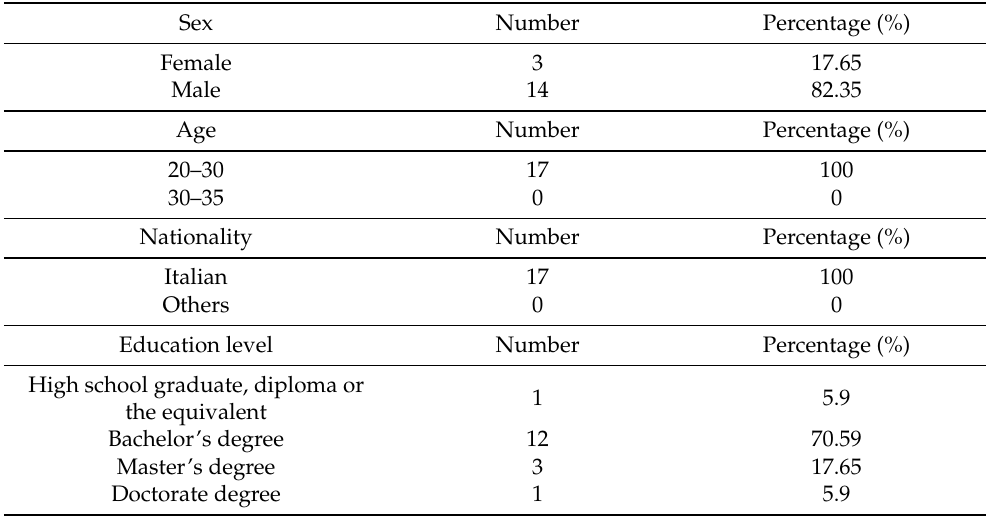
Table 2. Participants’ demographic